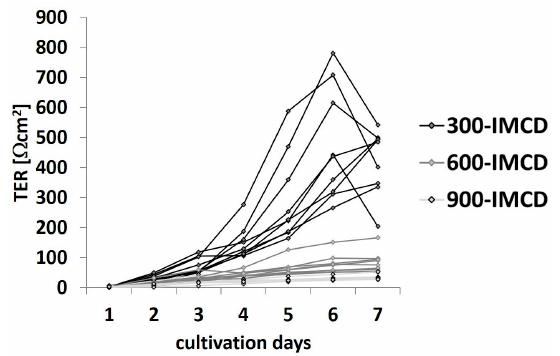
Figure 5. Time course of transepithelial resistance (TER) under culture conditions after seeding for nine different preparations with the filters of 300-IMCD, 600-IMC, and 900-IMCD, respectively.